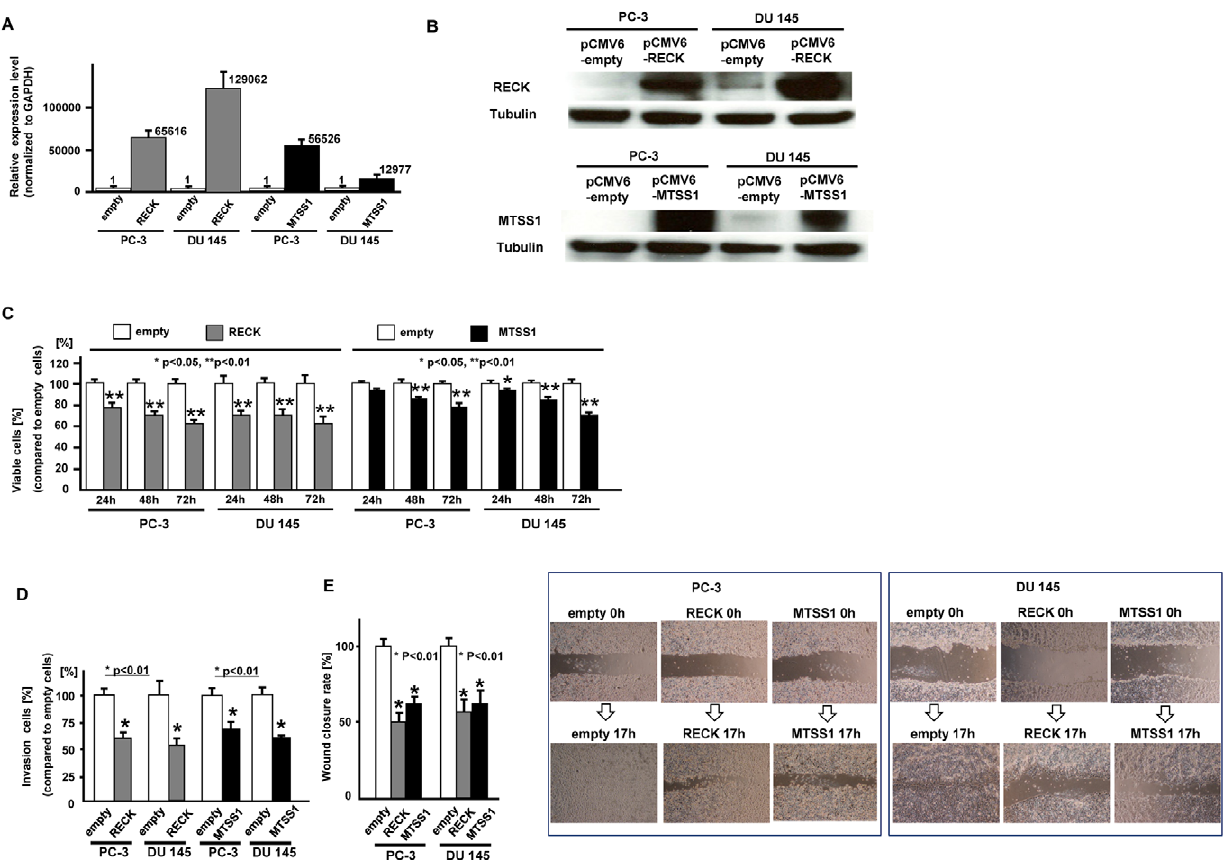
Figure 6. Effect of RECK and MTSS1 over-expression on prostate cancer cell function. At 24 hours after transfection of either pCMV6- empty, pCMV6-RECK or pCMV6-MTSS1 into prostate cancer cells (PC-3 and DU 145), RECK and MTSS1 expression levels were verified by real time RT- PCR (A) and Western analysis (B) C. Cell viability assay, D. Invasion assay, E. Wound healing assay, Error bars represent 6 S.D. (standard deviation).